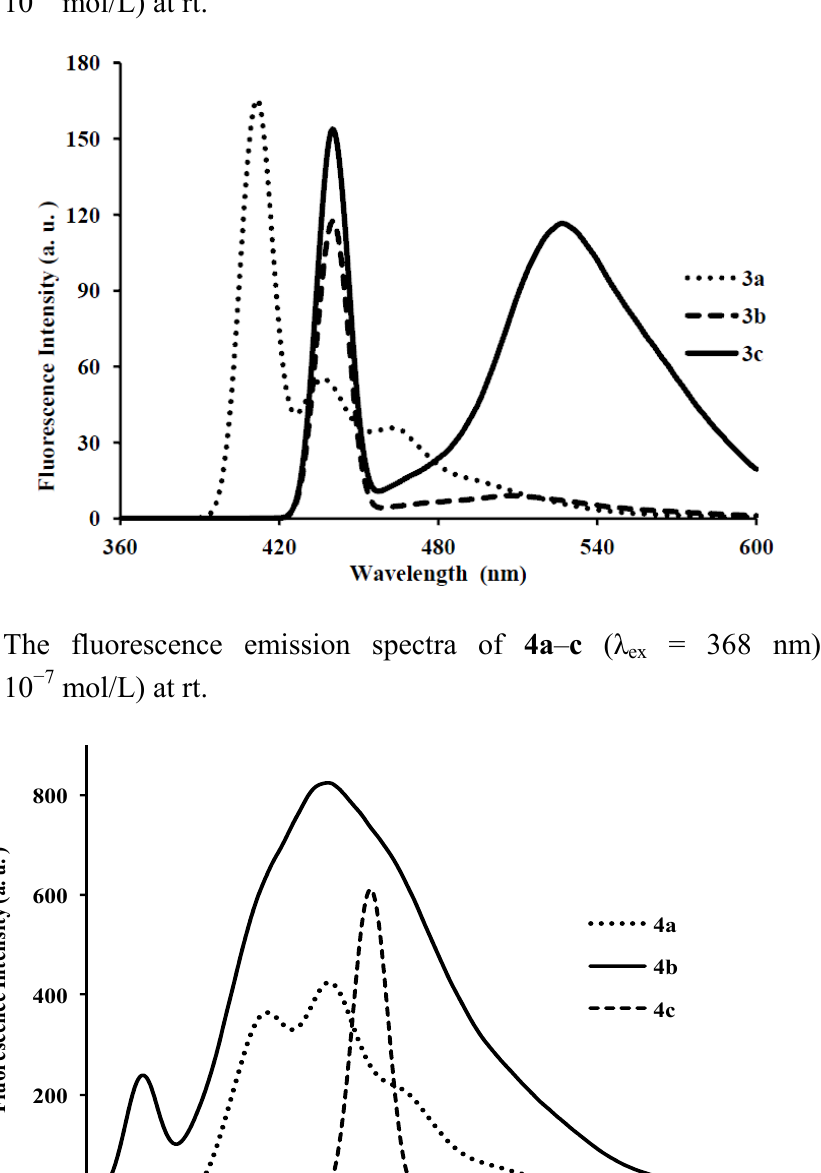
= 385 nm) in DMF ex